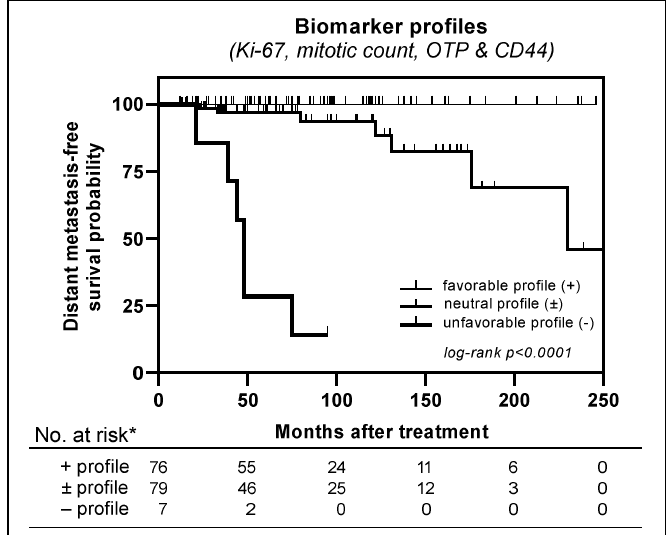
Figure 3. Distant metastasis-free survival curves estimated using Kaplan–Meier method for three biomarker profiles; + (favorable) profile: Ki-67 < 5%, mitotic count < 2 per 2 mm 2 , OTP and CD44 positivity;—(unfavorable) profile: Ki-67 ≥ 5%, mitotic count ≥ 2 per 2 mm 2 , and loss of OTP and/or CD44 expression; ± (neutral) profile: one or two characteristics of (un)favorable profile; * excluding nine patients due to stage IV disease at diagnosis ( n = 7) or missing CD44 values ( n = 2).